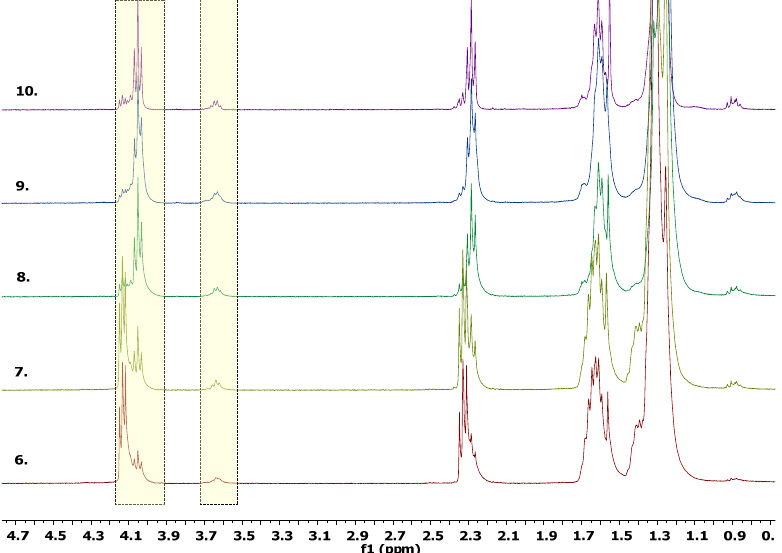
Figure 1. Superimposed 1 H-NMR spectra of the products formed in the reactions 6–10 (see Table 2) recorded in CDCl 3 .